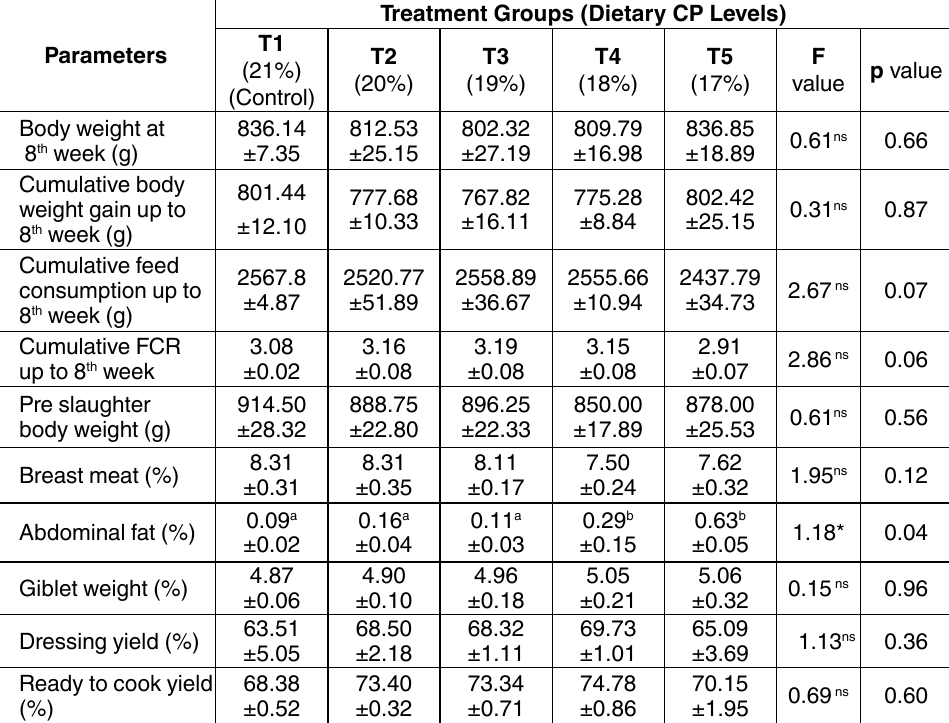
table 4. Effect of different dietary treatments on body weight, feed consumption and carcass traits of Gramasree male chicks up to eight weeks of age